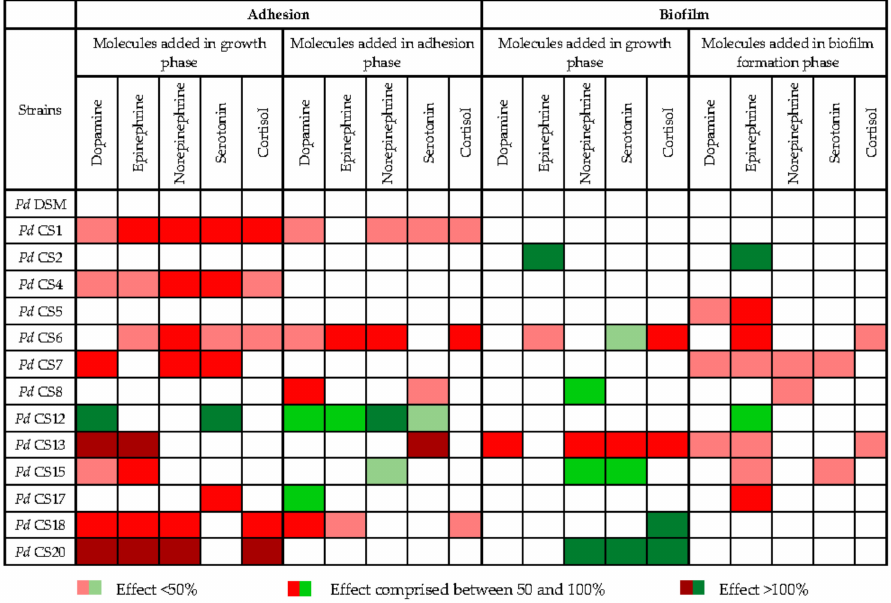
Figure 4. Impact of dopamine, epinephrine, norepinephrine, serotonin and cortisol on the adhesion and biofilm formation capacity of 14 strains of P. distasonis. Pd: P. distasonis . Red square indicates a significant reduction of the adhesion/biofilm formation capacities of the strains. Green square indicates a significant improvement of the adhesion/biofilm formation capacities of the strains. White square indicates no impact of the stress-induced molecules on the properties of the strains. Statistical analyses were done using the t -test. Data represent mean from triplicate for each condition (n =